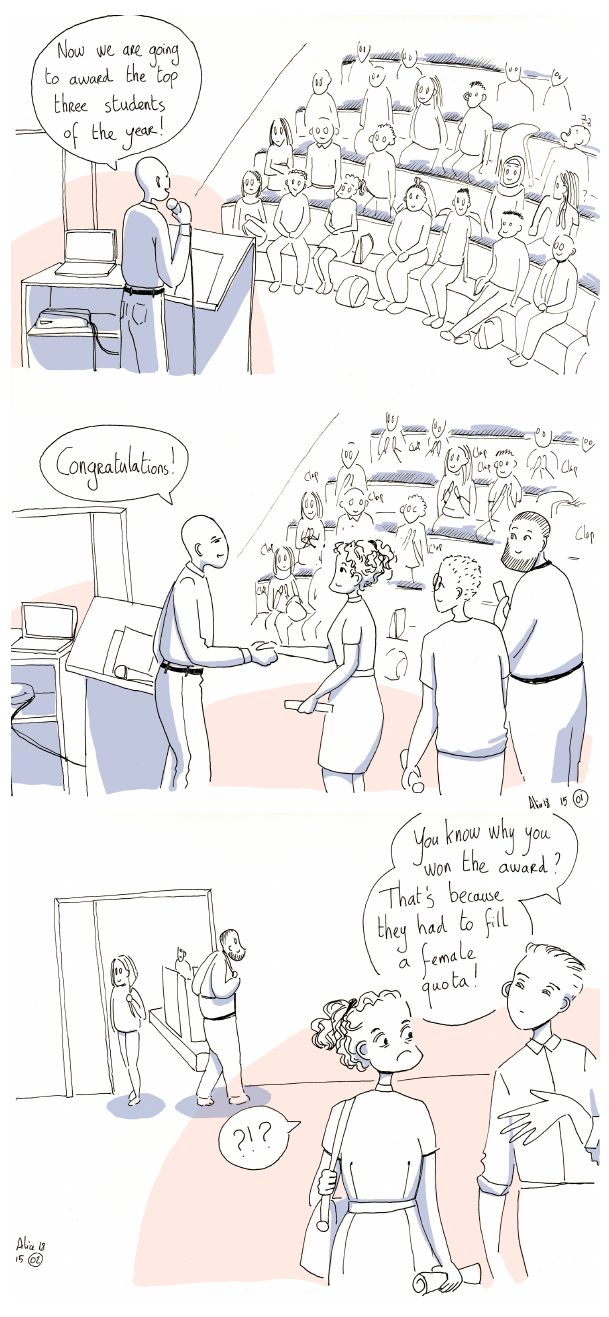
Figure 8. A young female is receiving an award for being among the top three students of her year. Her merit is questioned and at- tributed to an imaginary female quota. Example of the “Modern sexism and Neosexism” category. Comic strip title: “Female quota” (DTRH team, 2019a; Adenis, 2019). All comics are hand-drawn by Alice Adenis – distributed under the Creative Commons Attribution 4.0